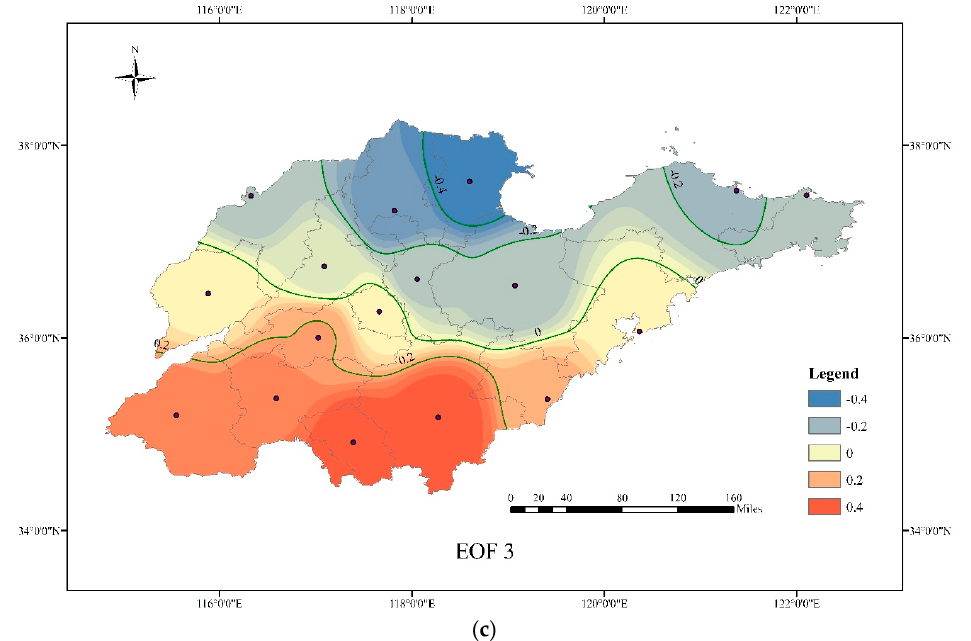
Figure 5. The spatial distribution of the main patterns of EOF ( a , EOF1; b , EOF2; c , EOF3). The second EOF pattern (EOF2) explained 5.46% of the total variance in daily MDA8 ozone, showing the spatial difference in ozone distribution in Shandong. Almost exactly the opposite of the EOF1, the high-value center was in the Peninsula Coastal area in EDF2, while the low-value center appeared in the northwestern part of Shandong and the northern part of LZ. The seasonal variations of the time weight coefficient series are not obvious, and positive or negative values appeared throughout the whole year; however, the summer was slightly higher than other seasons (Figure S3).